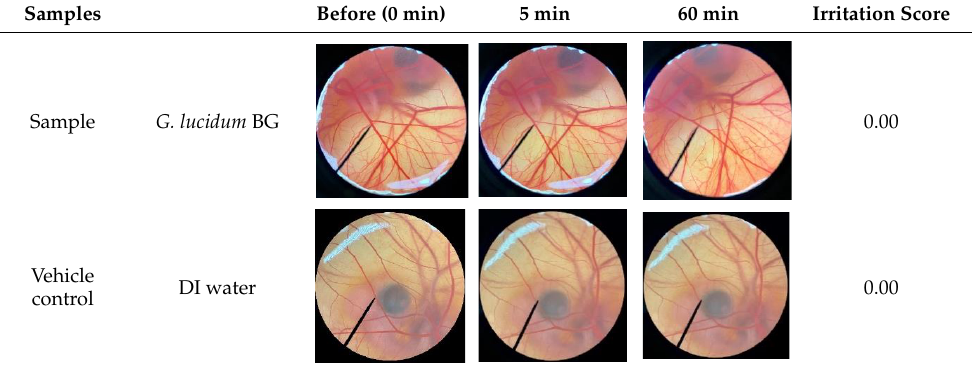
Figure 3. Effect of antler-type G. lucidum BG at various concentrations on cell viability of peripheral blood mononuclear cell (PBMC) from 5 healthy volunteers (#1 – #5). Data were expressed as Mean ± SD values from 3 replications.